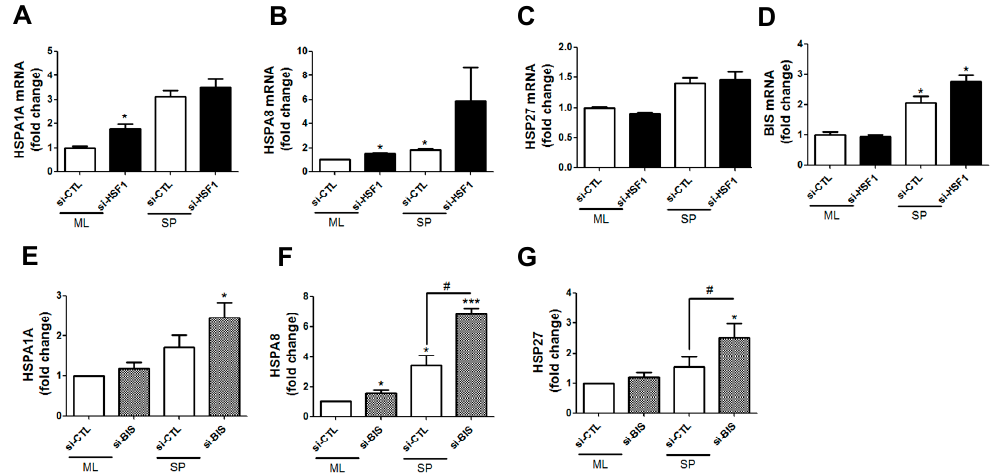
Figure 3. Effects of HSF1 ( A – D ) or BIS ( E – G ) depletion on transcription of HSF1 target genes.